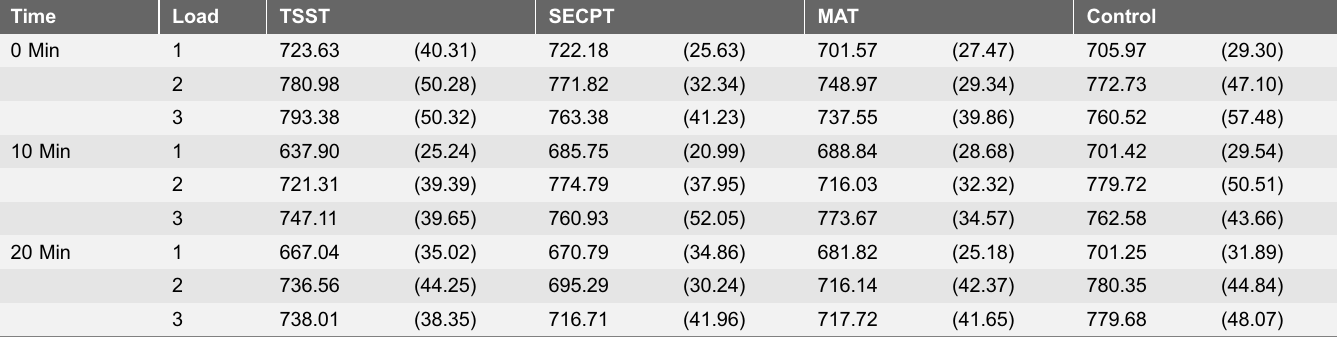
Table 2. N-Back Reaction Time (seconds) as a function of Stress and Load (means and SE) at baseline and 0-, 10- and 20-minutes